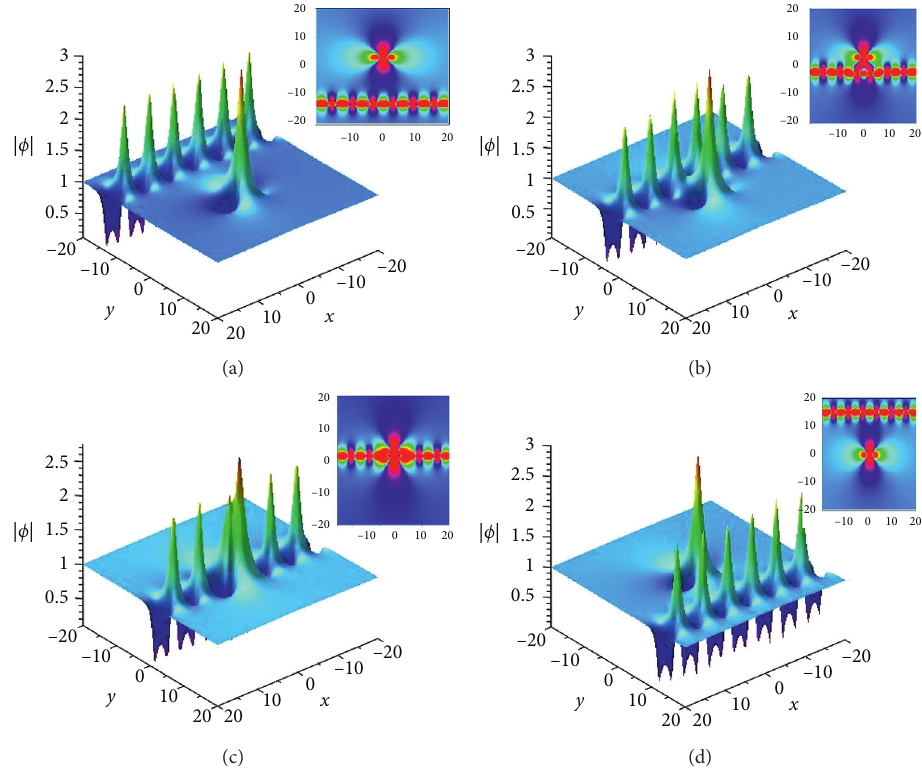
Figure 11: The superposition of a lump and one breather with parameters κ � 1 , λ different values of η 0